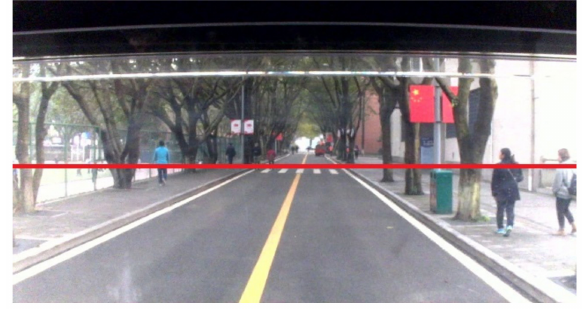
Figure 3. Region of